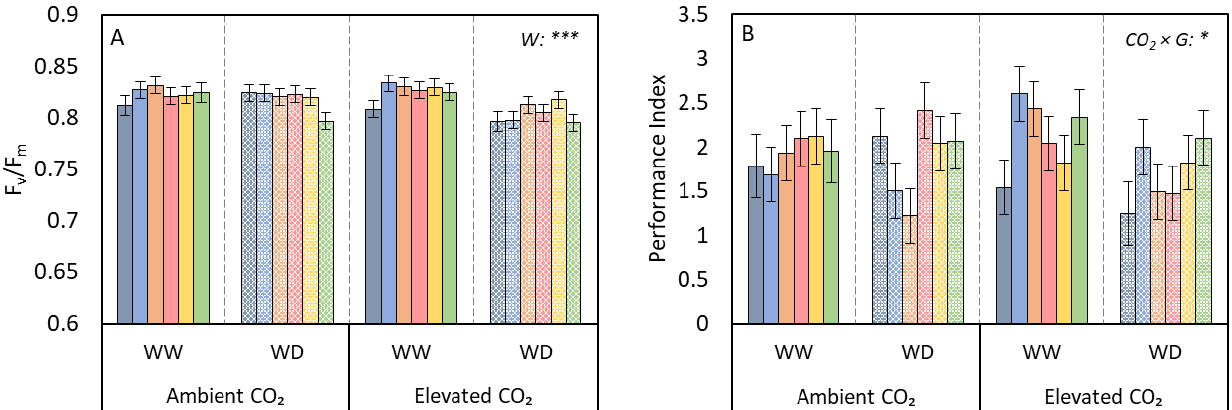
Figure 4. Maximum quantum efficiency of PS II (F v /F m ) ( A ) and performance index ( B ) measured on six genotypes of cacao grown under well-watered (WW) and water deficit (WD) conditions in ambient and elevated CO 2 conditions. Error bars are standard error of the mean. Grey bars: CL 19/10; blue bars: ICS 1, orange bars: IMC 47; pink bars; POUND 7/B; yellow bars: SCA 6; green bars: SPEC 54/1. Where statistical differences were identified between the main factors these are noted on the top right of each plot. The asterisks indicate the factors and interactions which had a significant effect on each response variable (W: water treatment; CO 2 : CO 2 treatment; G: genotype; * p < 0.05; *** p < 0.001).